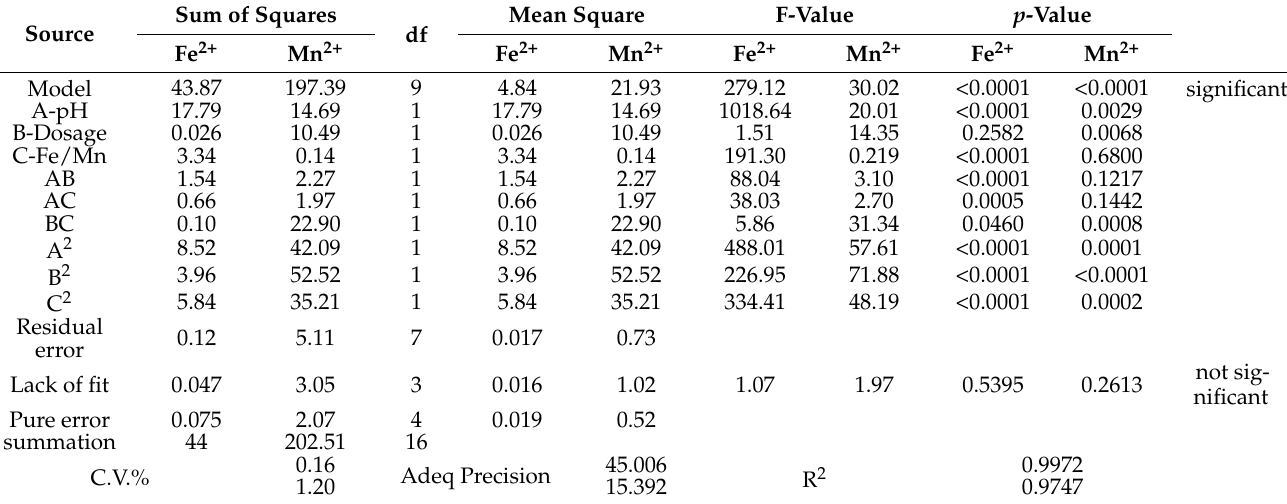
Table 4. Analysis of variance of regression